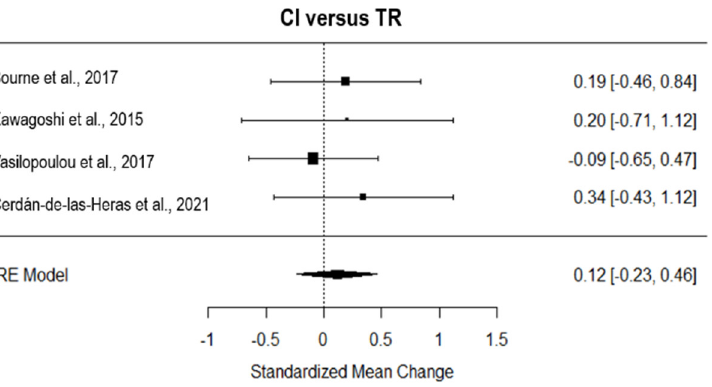
Figure 2. Forest plot on the effect of TR on functional capacity compared to NI. TR, TR; NI, no intervention [8,29,33–35,38,41]. Ref. [31] was not included in the analysis based on the leave-one-out analysis.